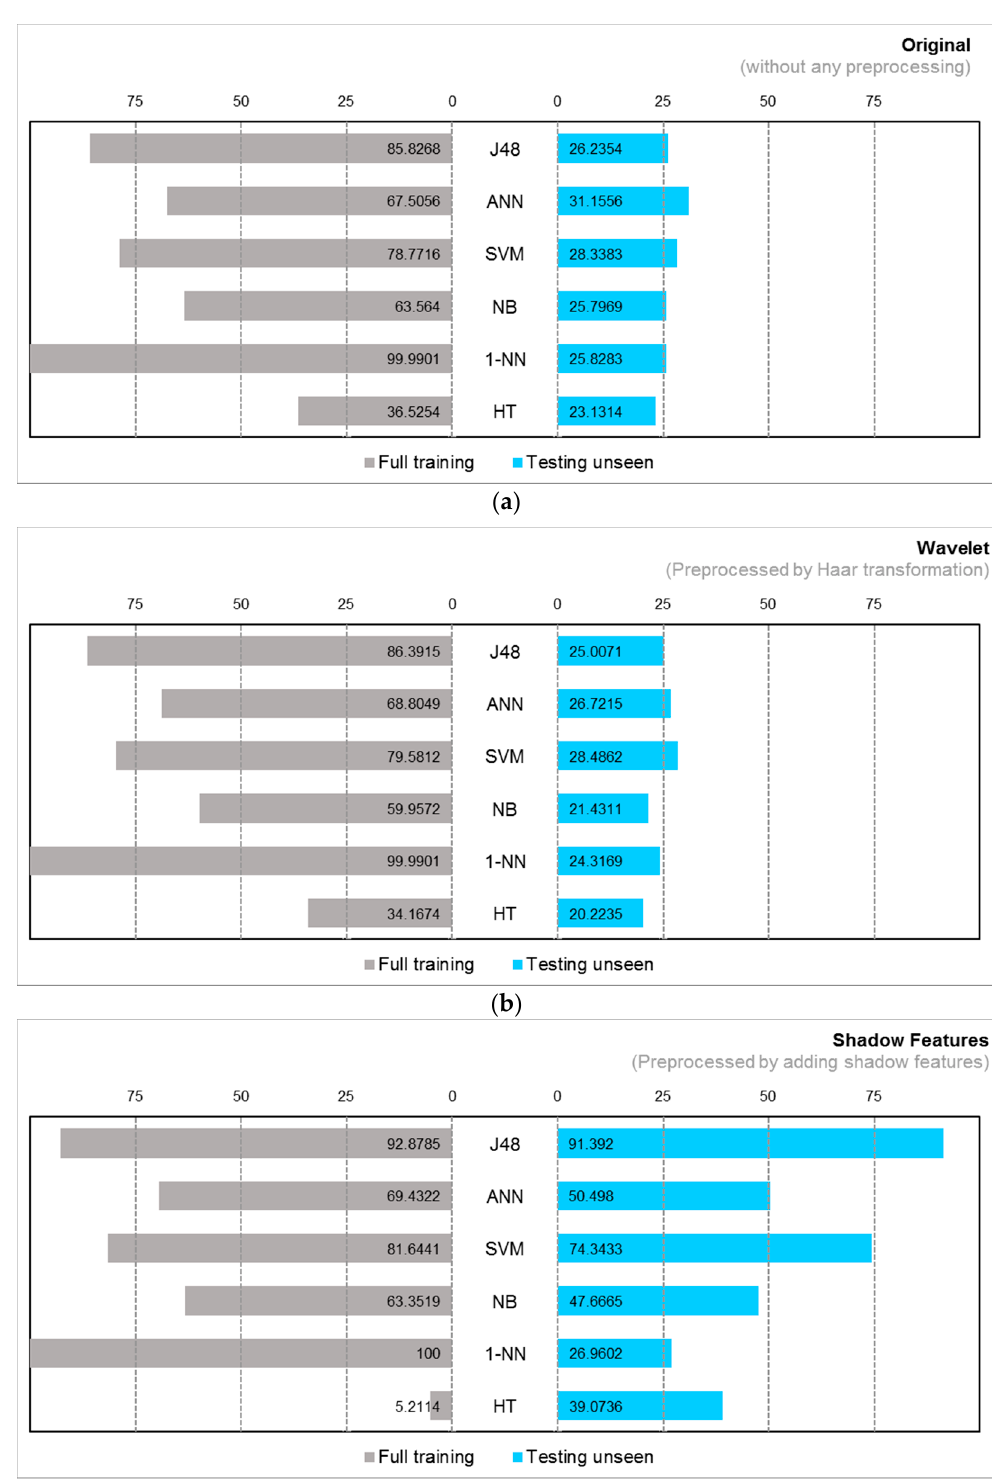
Figure 8. Accuracy of classifiers in accelerometer data with different pre-processing strategies for ( a ) Original; ( b ) Wavelet; and ( c ) Shadow Features.